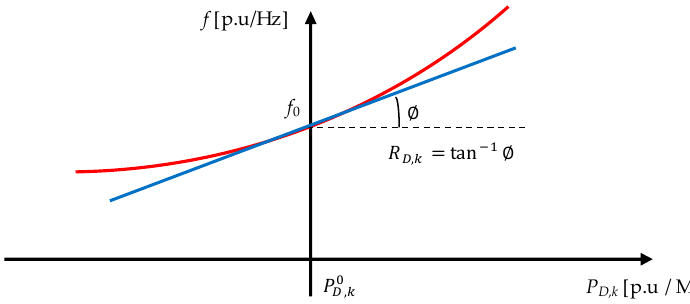
Figure 3. P-f response characteristic of demand k